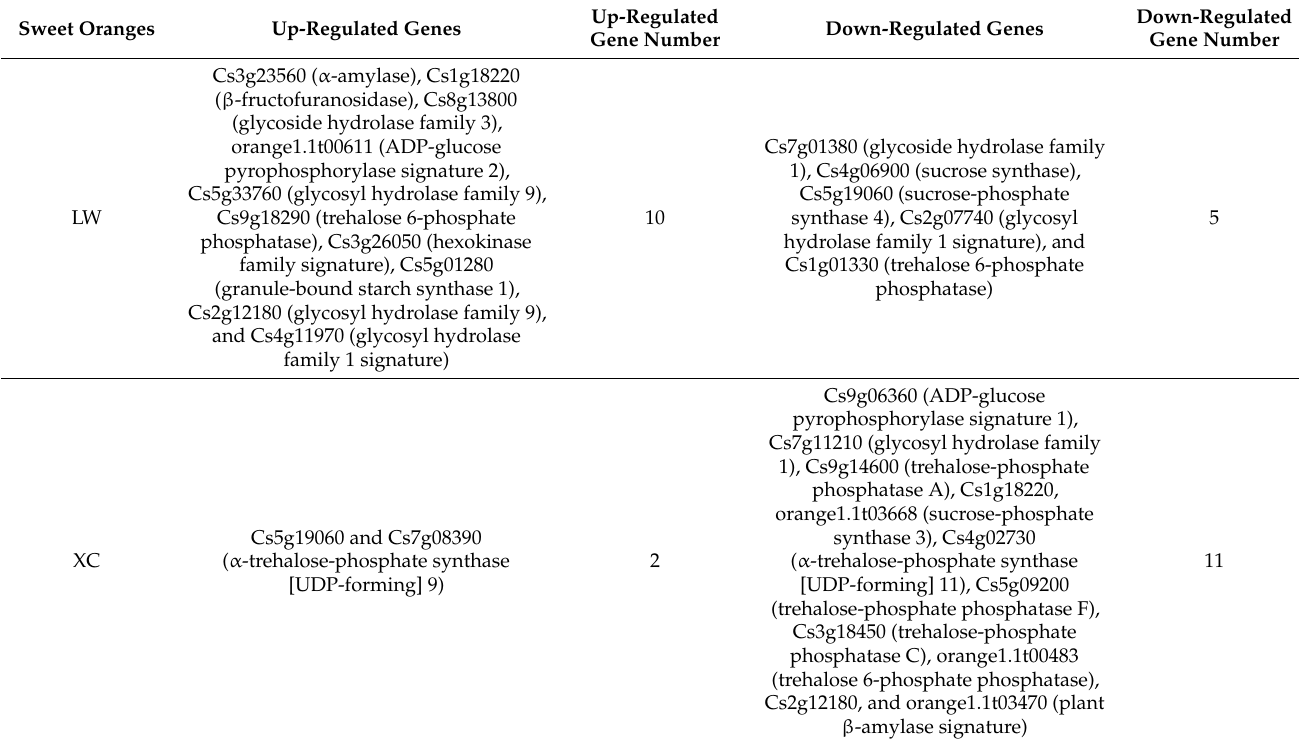
Table 2. Gene species of starch and sucrose metabolism.